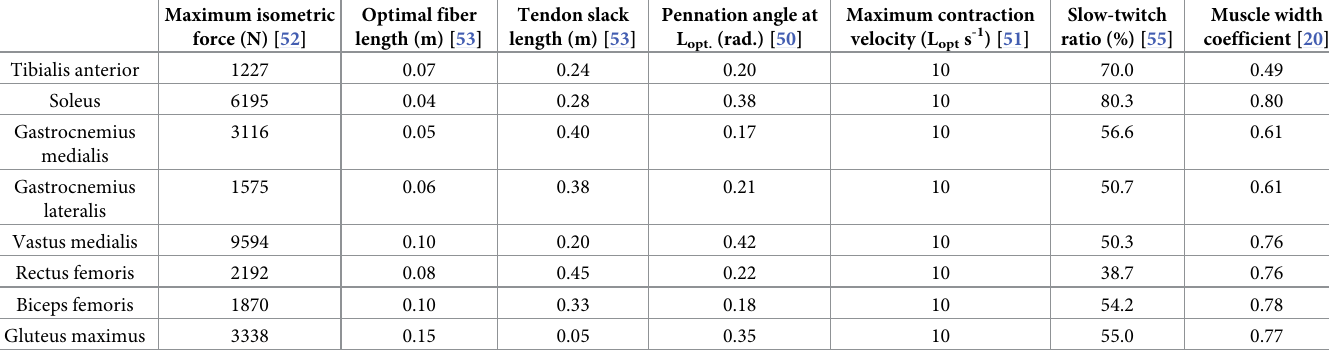
L opt is optimal fiber